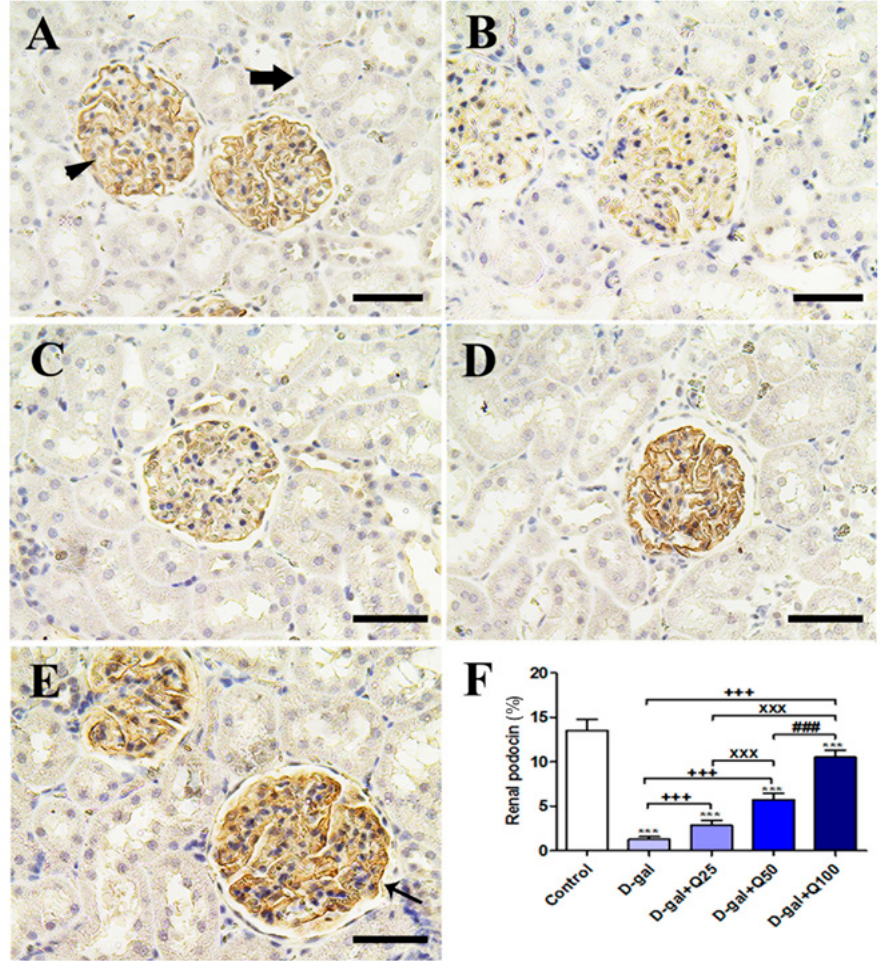
Figure 8. Immunohistochemical staining of rats’ kidney with podocin. ( A ) Negative control group showing high reaction in the renal glomerulus (arrowhead) and no reaction in the renal tubule (arrow). ( B ) D-gal group revealing weak podocin reaction. ( C) D-gal+Q25 group. ( D ) D-gal+Q50 group. ( E) D-gal+Q100 group. ( F ) Quantification of podocin in the renal tissues in different groups. Scale bar = 50 µm . Data were analyzed with one-way ANOVA followed by Tukey’s multiple comparison test. Error bars represent mean ± SD. ** *p < 0.001 vs control. +++ p < 0.001 vs D-gal. xxx p < 0.001 vs D-gal+Q25. ### p < 0.001 vs D-gal+Q50.